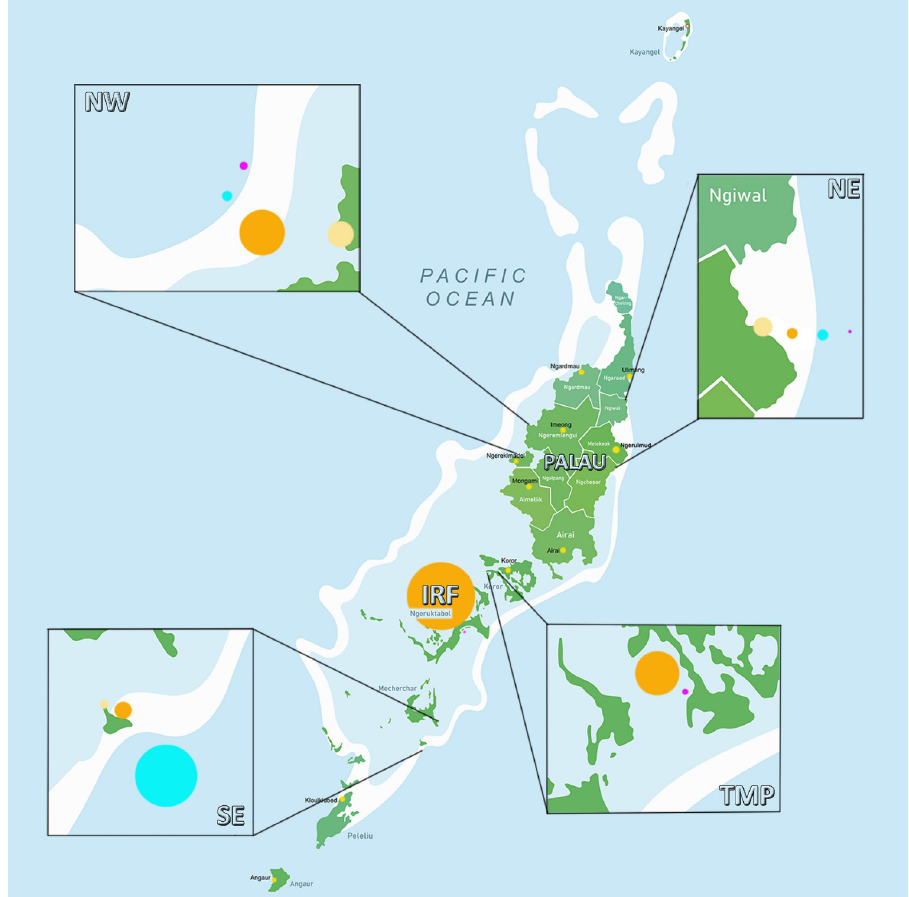
Fig 3. Map of the representation of the quantity of MPs found according to the type of sample. Blue: Outer sediments from the barrier reef, Purple: water sample, Orange: Inner sediments from the barrier reef, Yellow: Beach